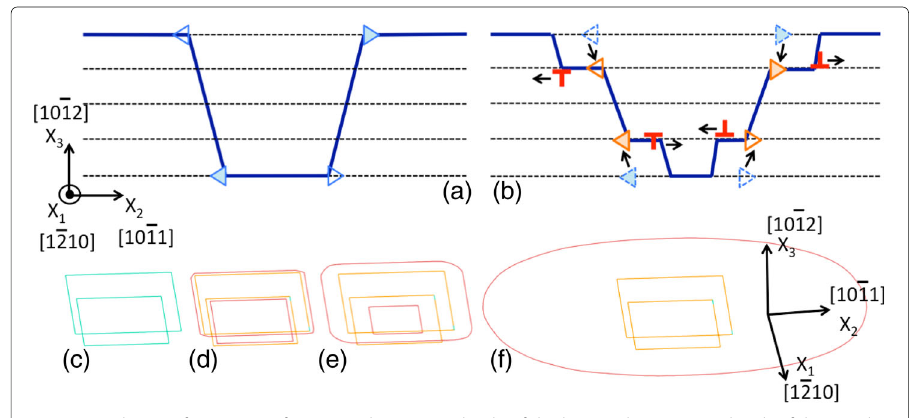
Fig. 7 Simulation of a twin interface crater by using a dipole of disclination loops. a 2D Sketch of the initial crater configuration (blue lines). Blue triangles denote wedge disclinations. b 2D sketch of the dynamics of the crater. Dotted horizontal lines denote adjacent planes parallel to the twin plane and separated by elementary steps h . Orange triangles show the new position of disclinations, leading to the nucleation of steps and edge dislocations, i.e. disconnections. c Initial dipole of square disclination loops forming the crater (blue lines). ( d , e , f ) Generation of dislocation loops (red lines) from the out of plane motion of disclination loops of opposite sign (orange lines). The lower dislocation loop shrinks while the upper one expands and reaches an equilibrium